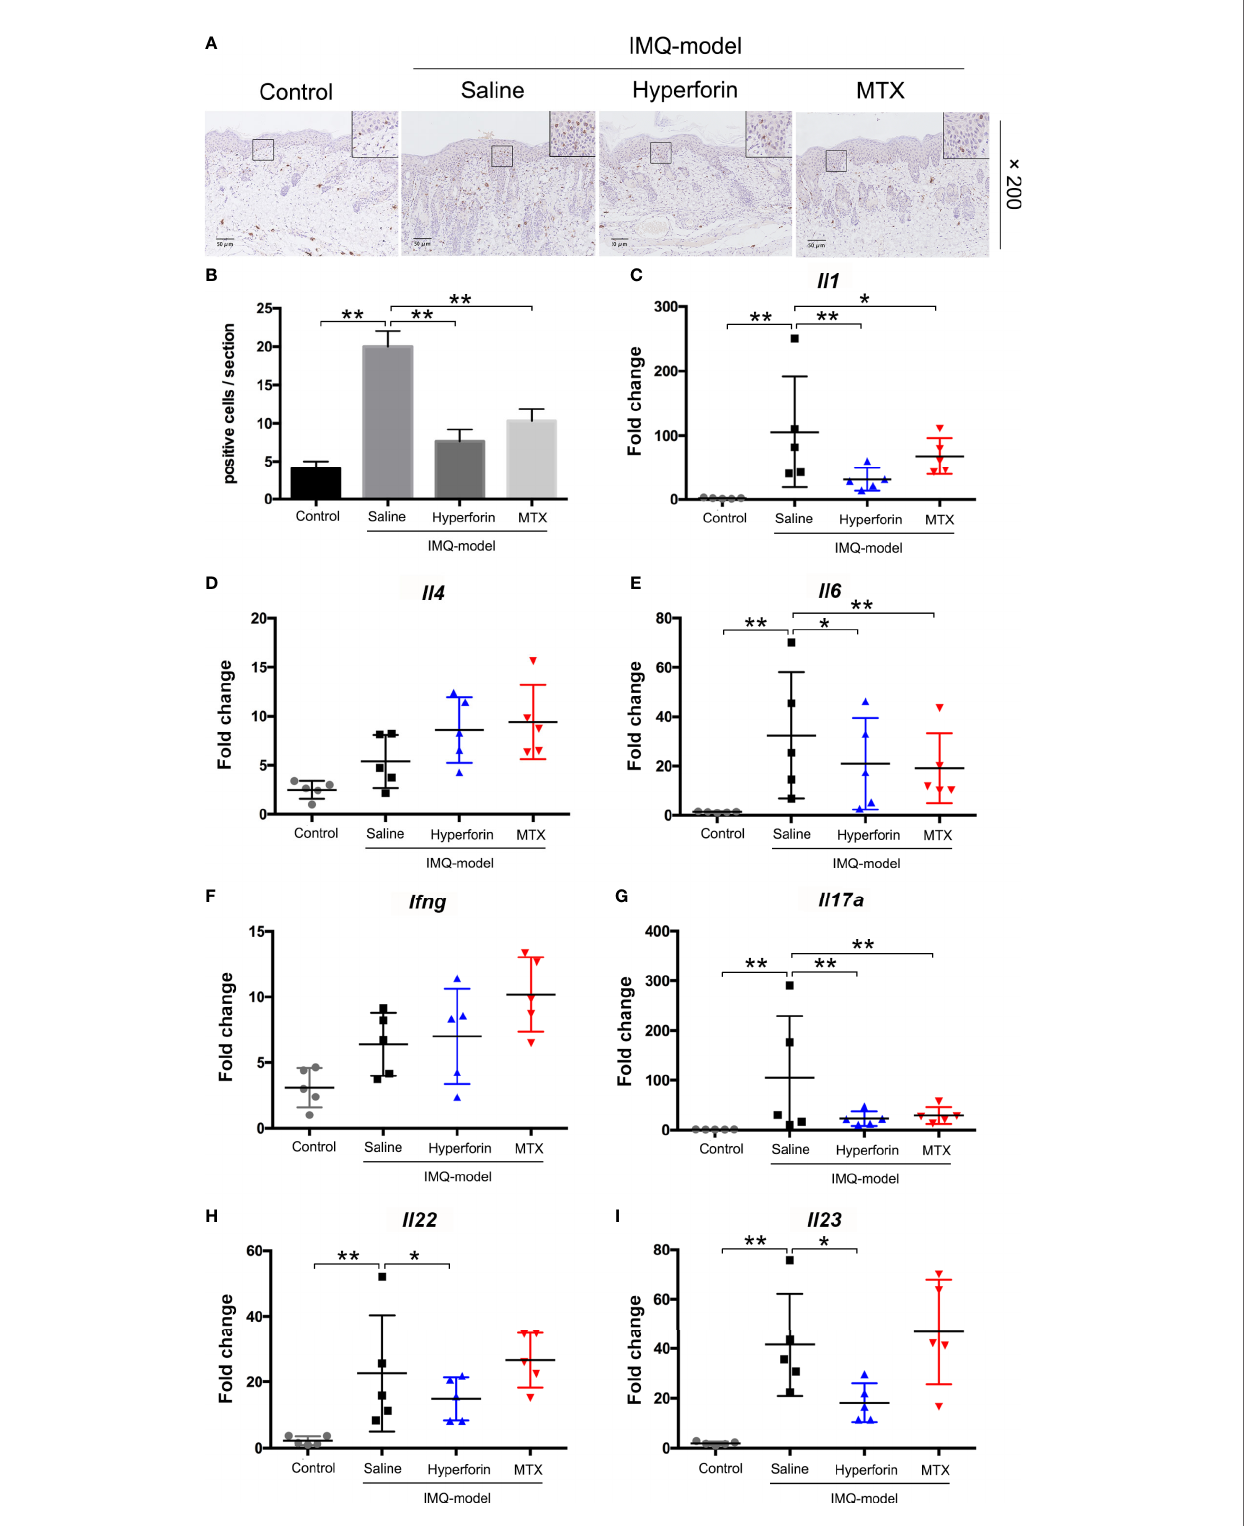
FIGURE 2 | Hyperforin inhibited in fl ammatory cell in fi ltration and in fl ammatory cytokines releasing in skin of IMQ-induced mice model. (A) Immunohistochemical staining of CD3 + cells in skin lesion. (B – I) The mRNA expression of psoriasis associated in fl ammatory cytokines in the skin lesion of mice model. Data are shown as mean ± SD(A – E). n=5 mice. *P < 0.05 and **P < 0.01 vs Model